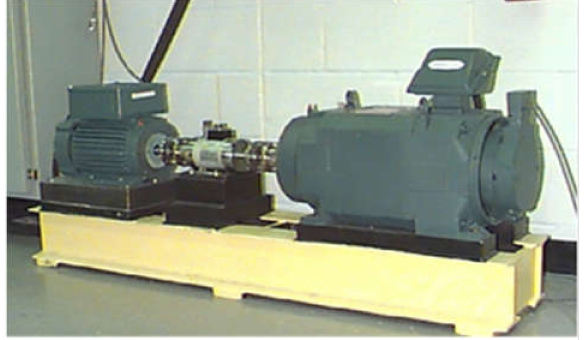
Figure 5. Test-stand.